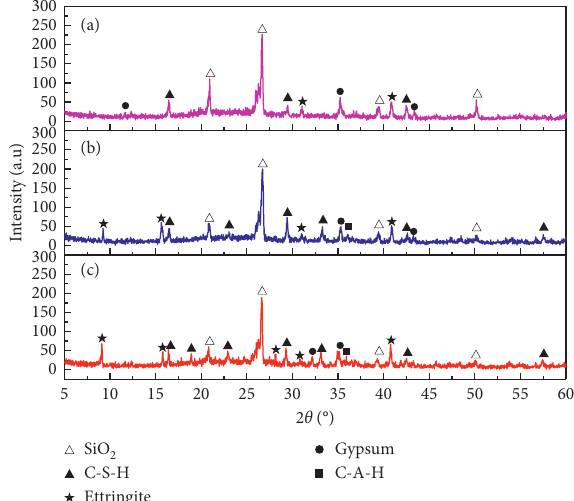
Figure 8: XRD patterns for CPB samples after curing at 60 ° C for 12hours: (a) RM, (b) PC, and (c)